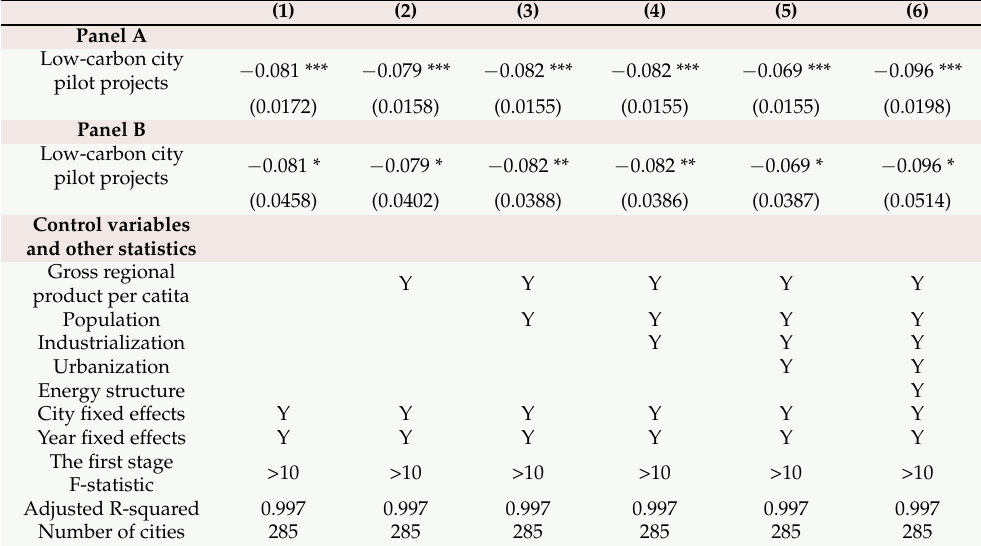
Table 4. Estimates in the impact on carbon from instrumental variable